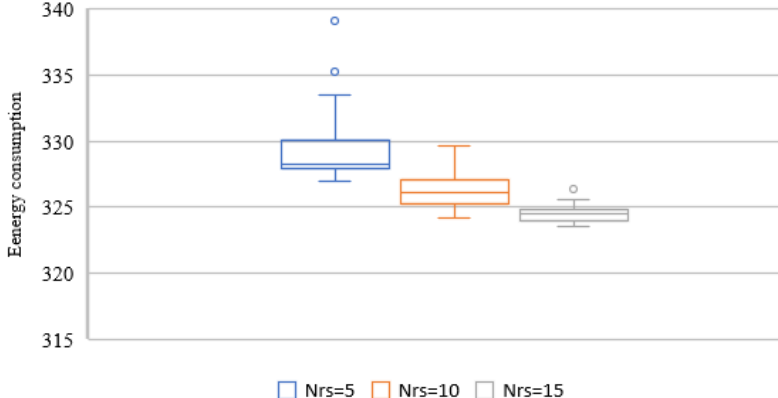
Figure 10. Box plot of objective function values.